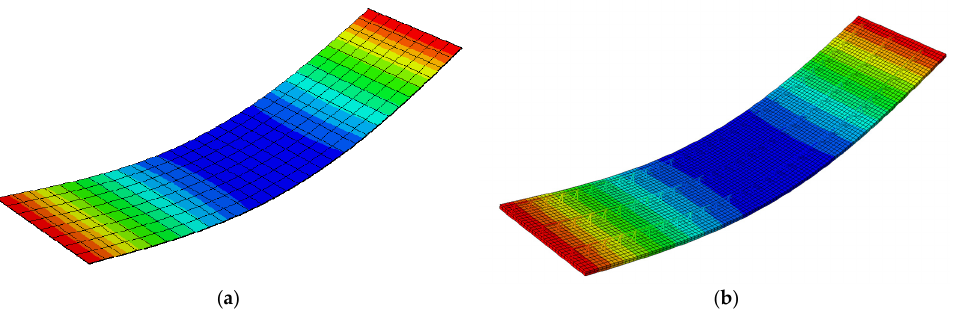
Figure 14. Comparison of vertical deflections: ( a ) RVE-2 shell model ABD; ( b ) full 3D FE model (Type-EQ). Figure 13. Comparison of vertical deflections: ( a ) RVE-1 shell model ABD; ( b ) full 3D FE model (Type-D). Table 6. The deflection at the mid-span computed using the full 3D (Type-EQ) model and three simplified shell models (based on RVE-2 homogenization FE model).